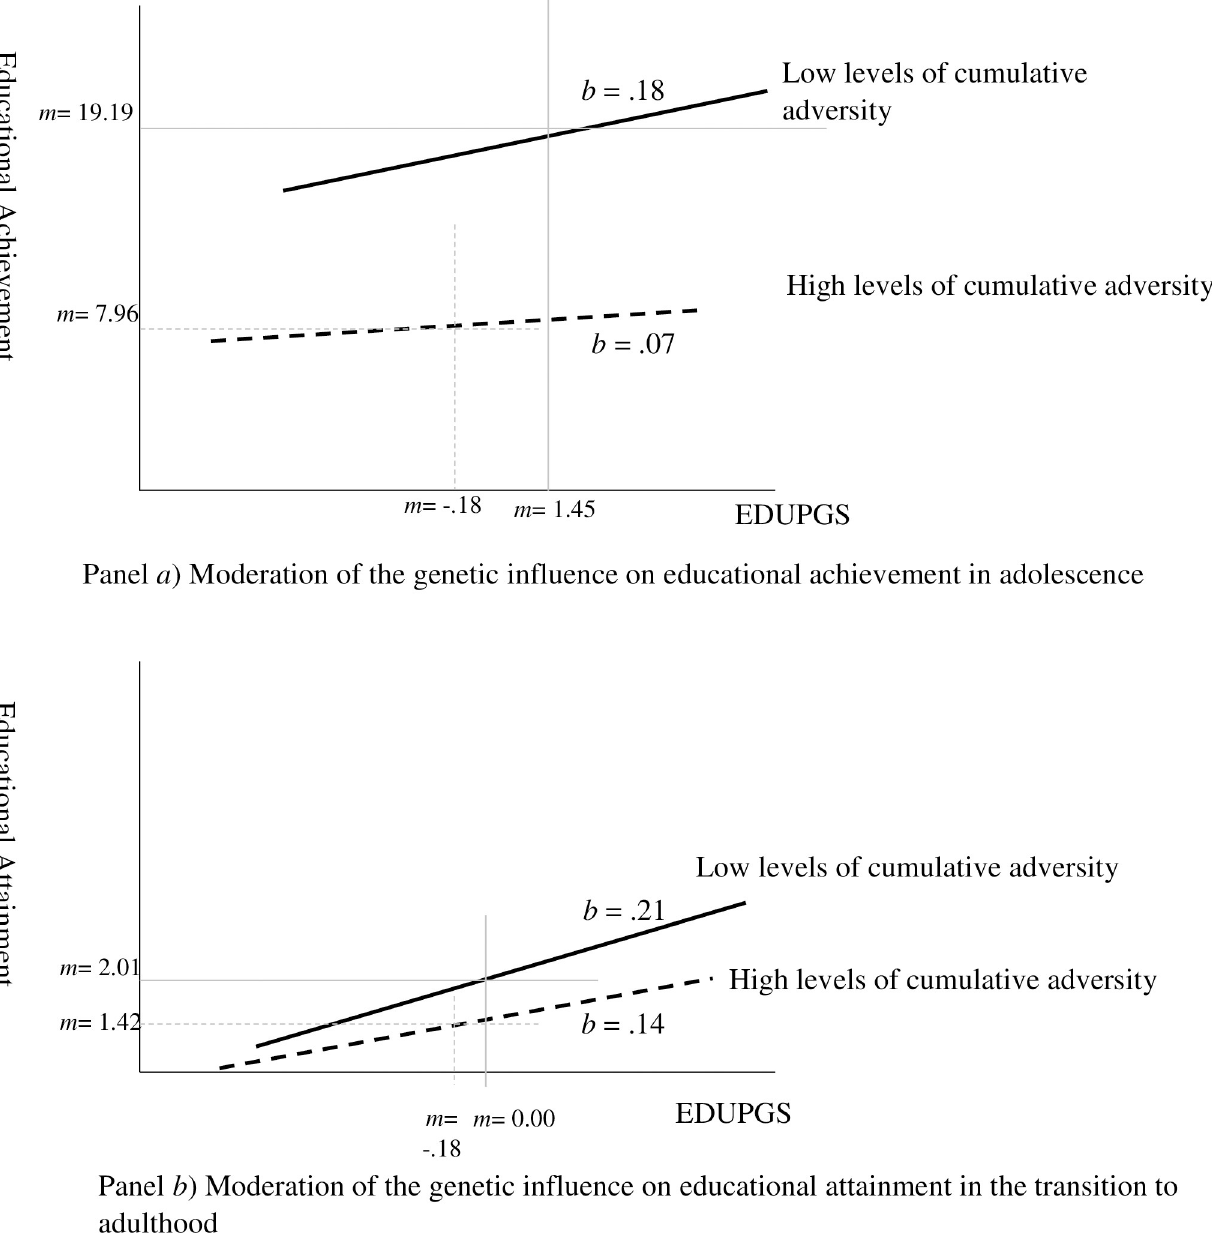
Fig 4. Moderation of the genetic influence on educational outcomes by early socioeconomic adversity (G × E). Note. b = Unstandardized slope coefficients. M = Mean. EDUPGS = Education Polygenic Scale.